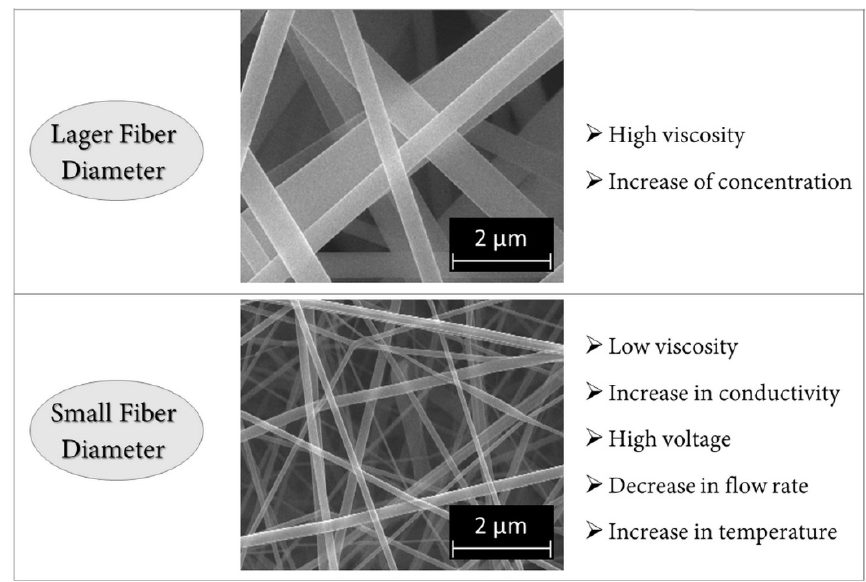
Figure 3. Summary of electrospinning parameters and their effects on fiber diameter.